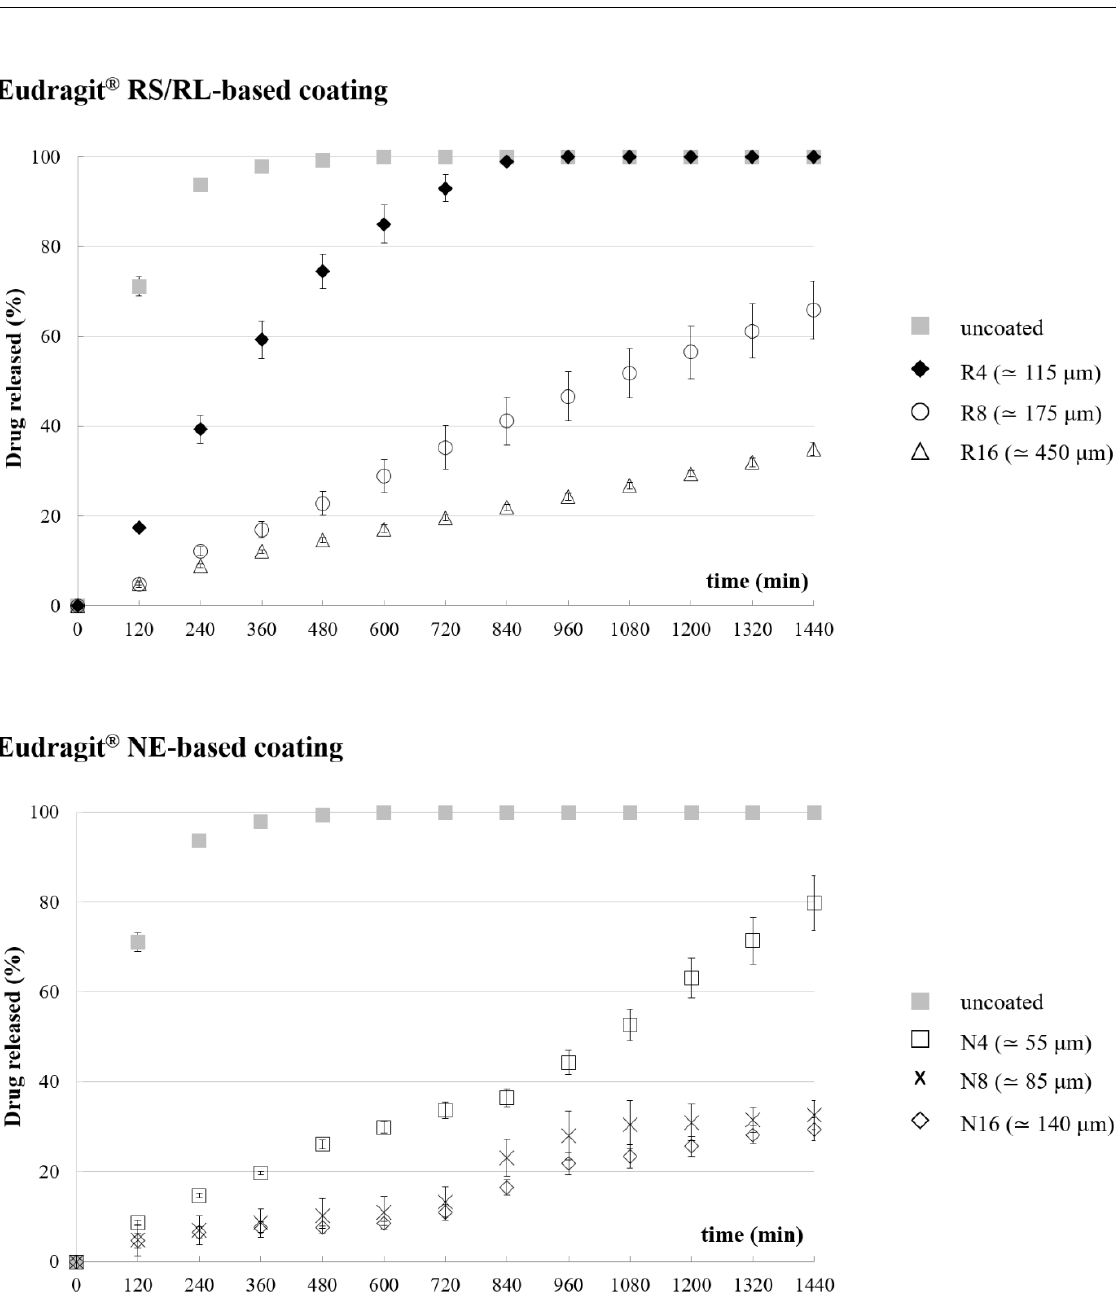
Figure 6. Average release profiles from uncoated and coated samples.